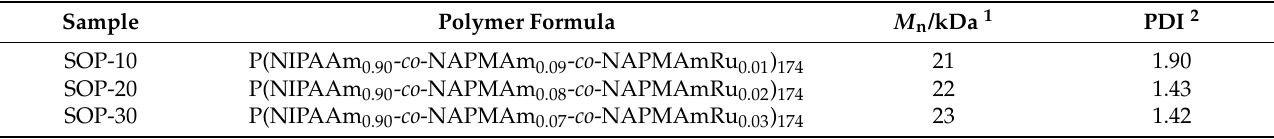
Figure 2. Synthetic scheme of the self-oscillating polymers. Table 1. Summary of the self-oscillating linear polymers.